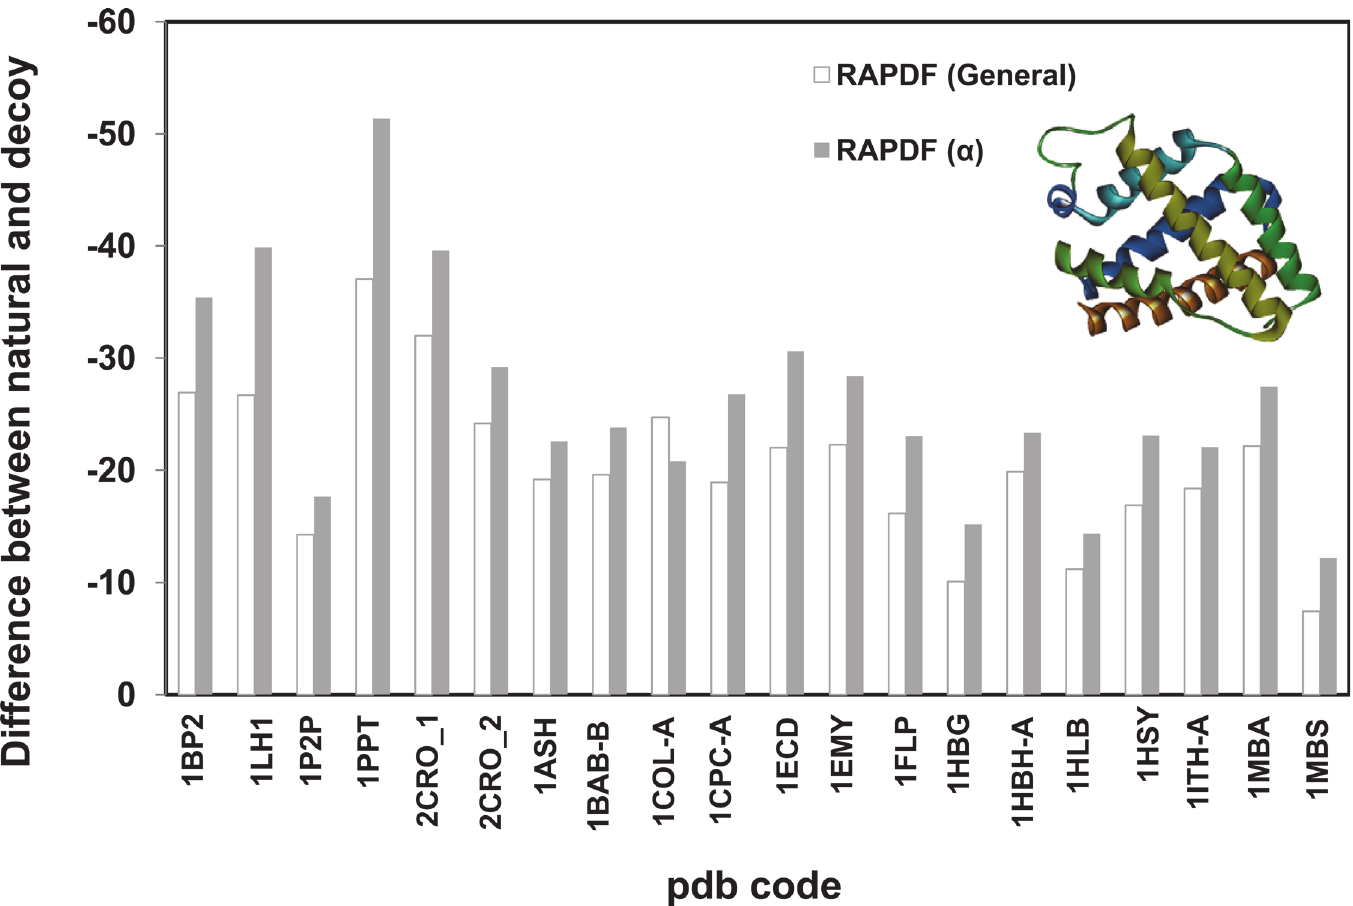
Fig 3. Evaluating the stability of α proteins using distance-dependant statistical potential based on α protein library (1007 proteins). RAPDF ( α ) represents the statistical RAPDF scores calculated using the α - database. First 6 sets were single misfold decoy sets and the rest 14 sets were from multiple decoy sets with a representative decoy